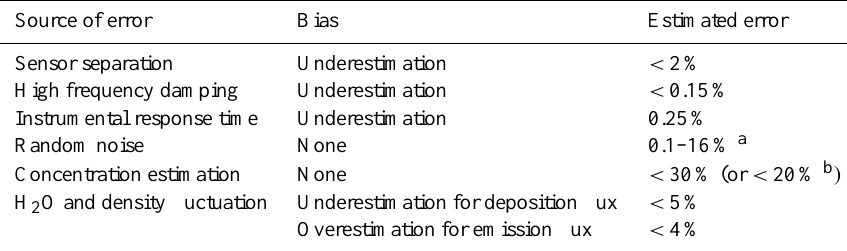
Table 1. Possible source specific flux estimation